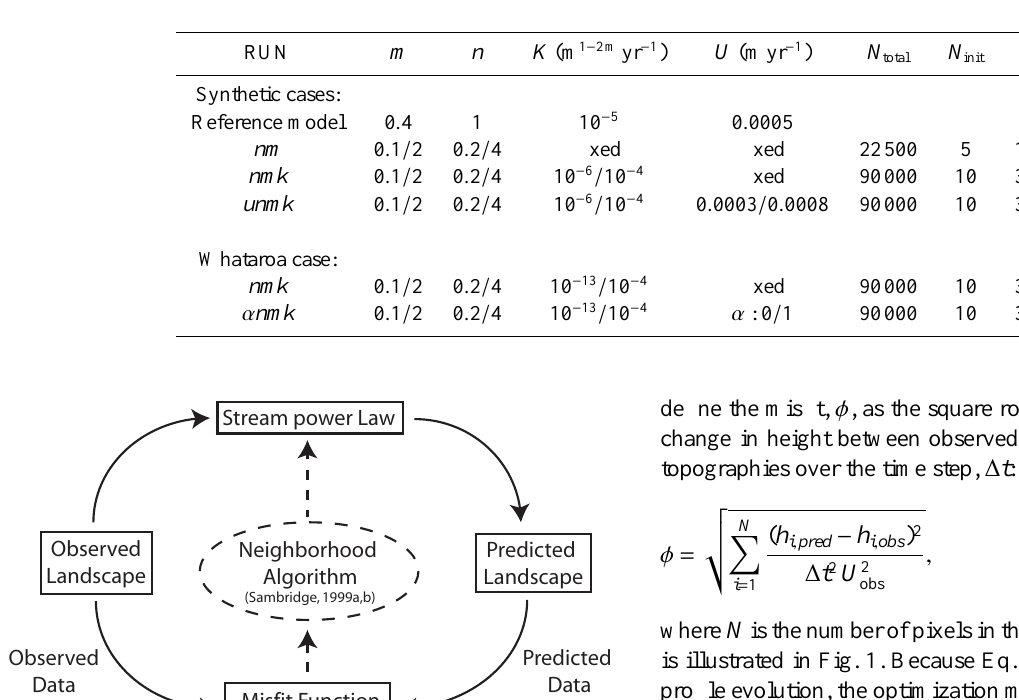
Table 1. Parameterization of the di ff erent runs